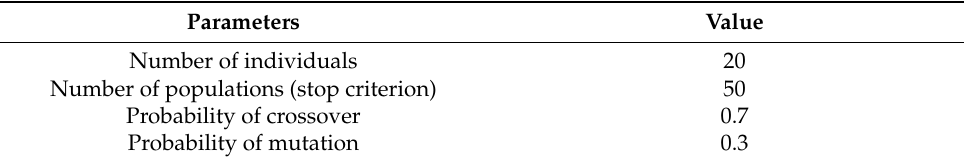
Table 2. Implemented in the proprietary program MGA parameters.